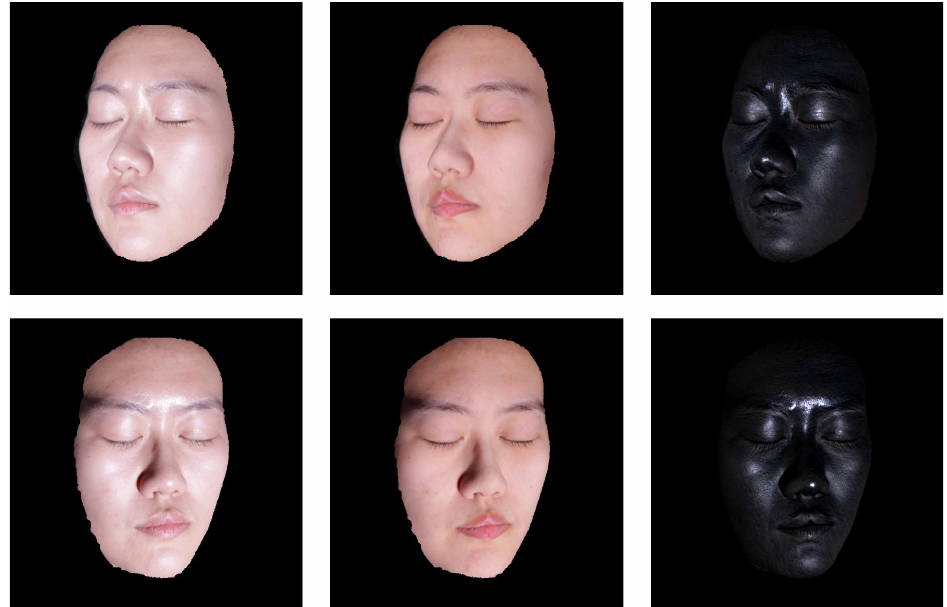
Figure 1. Examples of highlight removal of multi-view facial images. The first column presents facial images with highlights. The second and third columns show the corresponding highlight removal and specular images obtained through cross-polarization. Note that the images of the first two columns are not calibrated radiometrically for better